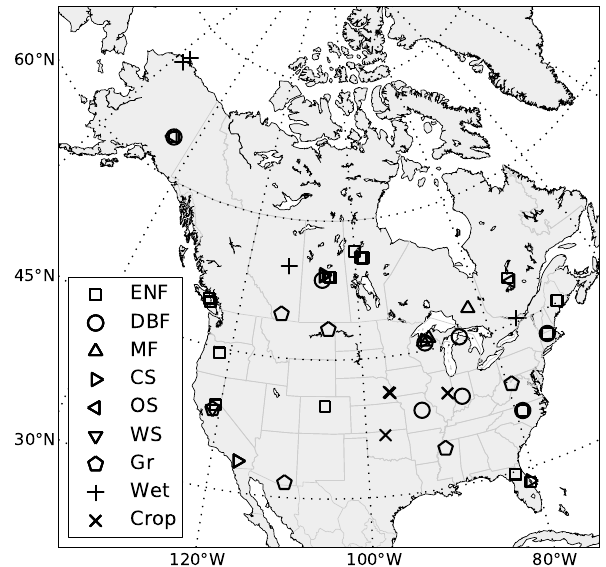
Fig. 1. The 65 eddy covariance flux tower sites from the FluxNet network (http://www.fluxdata.org) that provide observations for VPRM parameterization and VPRM flux residual calculation.